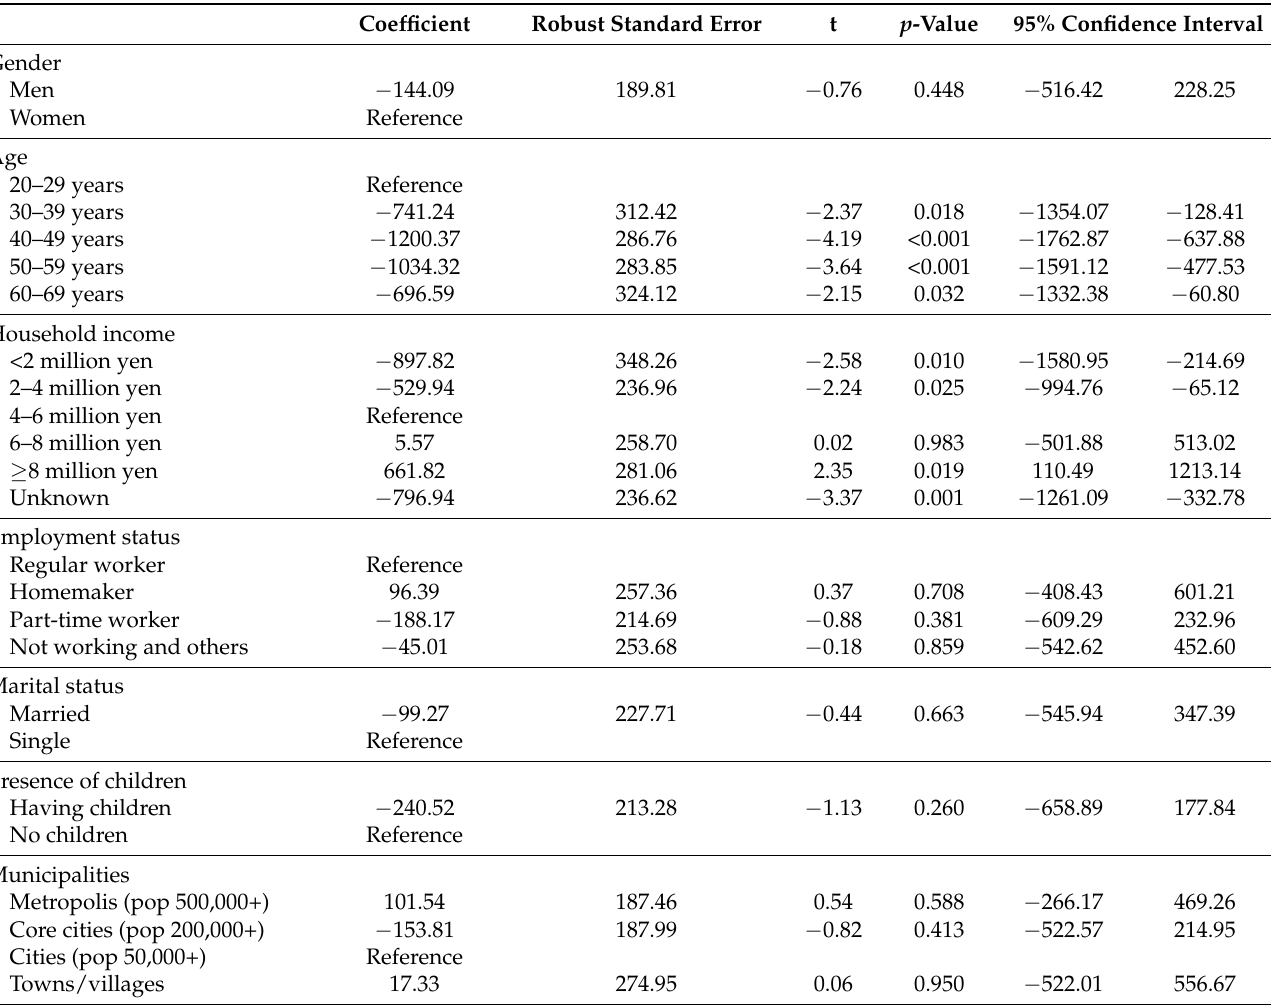
Table 4. Association between WTP values for dental checkups and study participants’ characteristics in the non-RDC group (multivariate Tobit regression